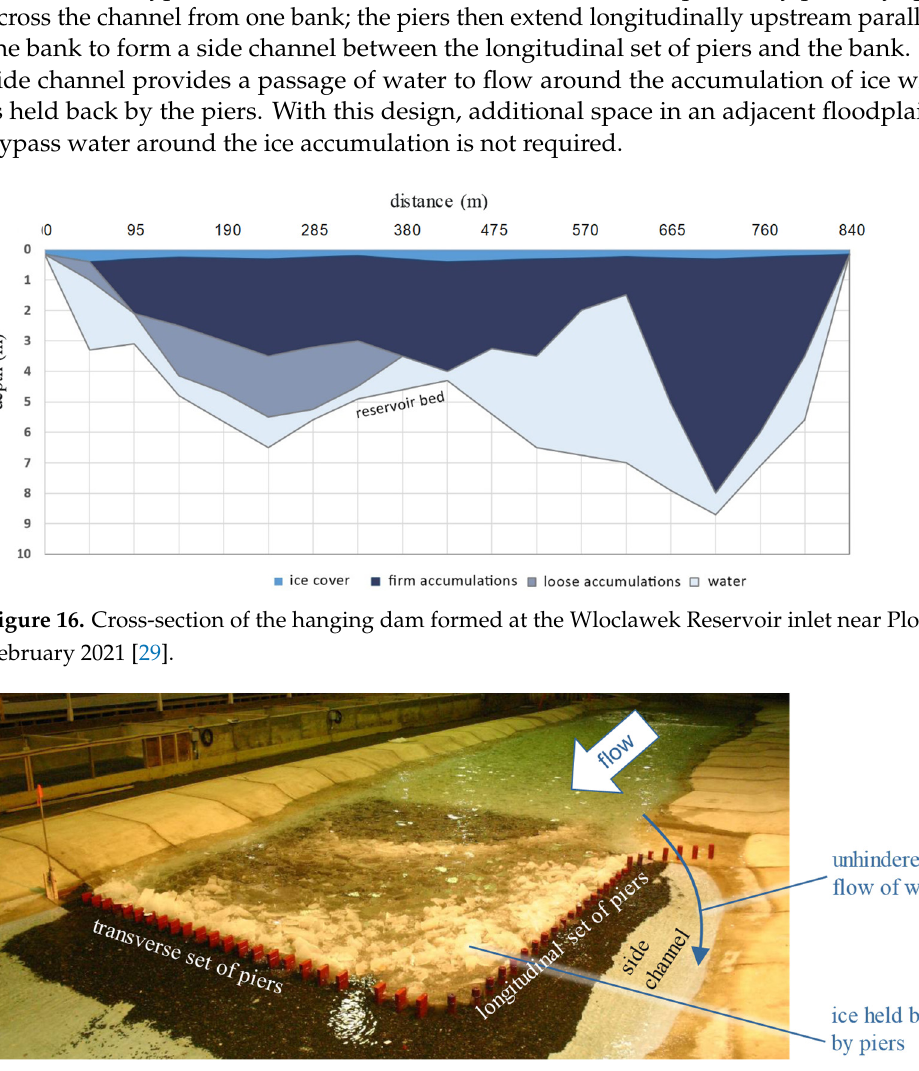
Figure 17. Ice-control structure (photo courtesy of US Army Cold Regions Research and Engineering Laboratory, Hanover, New Hampshire; used with permission). Laboratory, Hanover, New Hampshire; used with